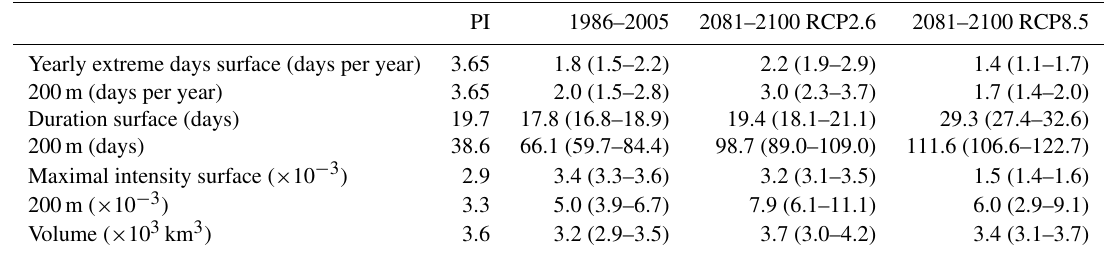
Table A1. Simulated global ensemble-mean (cid:127) A extreme-event characteristics, when extremes are defined with respect to a shifting baseline. Values in brackets denote ensemble minima and